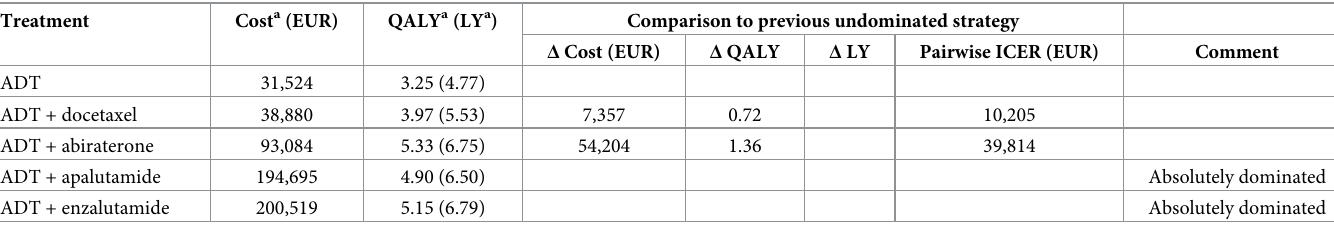
ADT, androgen deprivation therapy; EUR, euros; ICER, incremental cost-effectiveness ratio; LY, life year; QALY, quality-adjusted life year. a discounted.